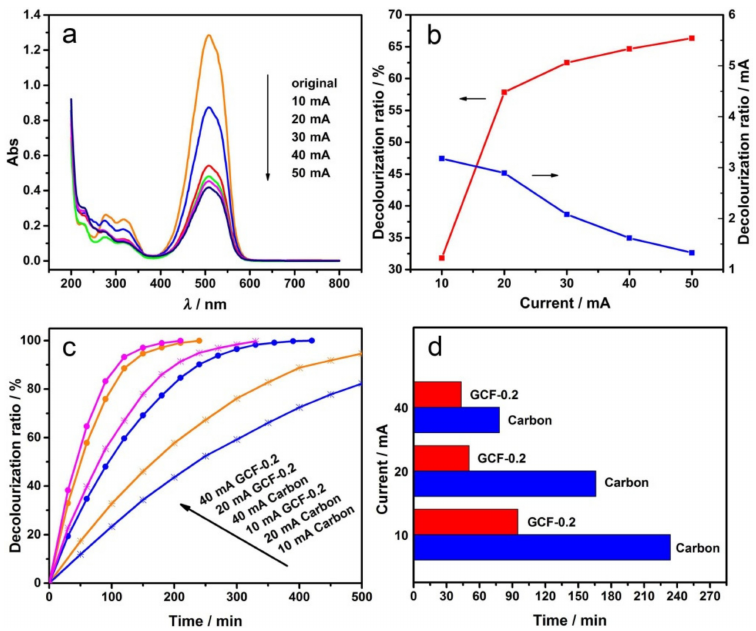
Figure 6. Effect of the current intensity: UV–visible absorption spectra of MO ( a ) and the decol- orization ratio curve ( b ) with GCF-0.2 cathode; decolorization ratio-time curve ( c ) and current intensity-time histogram ( d ) when the decolorization ratio is 50% with different cathodes at different current